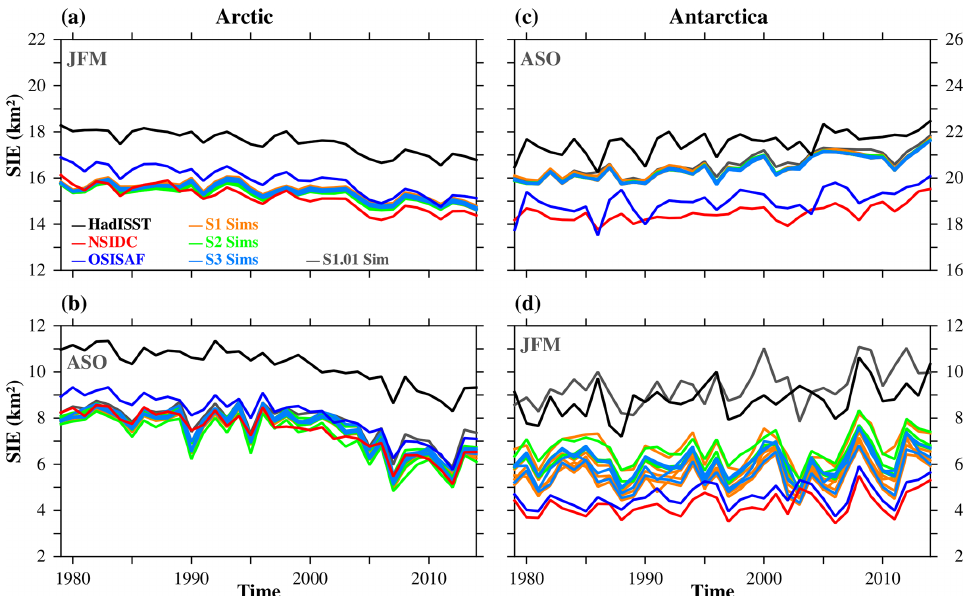
Figure 3. (a, b) Arctic and (c, d) Antarctic sea ice extent (SIE; in km 2 ) in (a, d) JFM and (b, c) ASO in the S1, S2, and S3 discretizations (in light red, green, and blue, respectively, with the single-category case, S1.01, in gray) in HadISST, NSIDC, and OSI SAF (in black, blue, and red, respectively). SIE is calculated as the total area of grid cells with concentration larger than